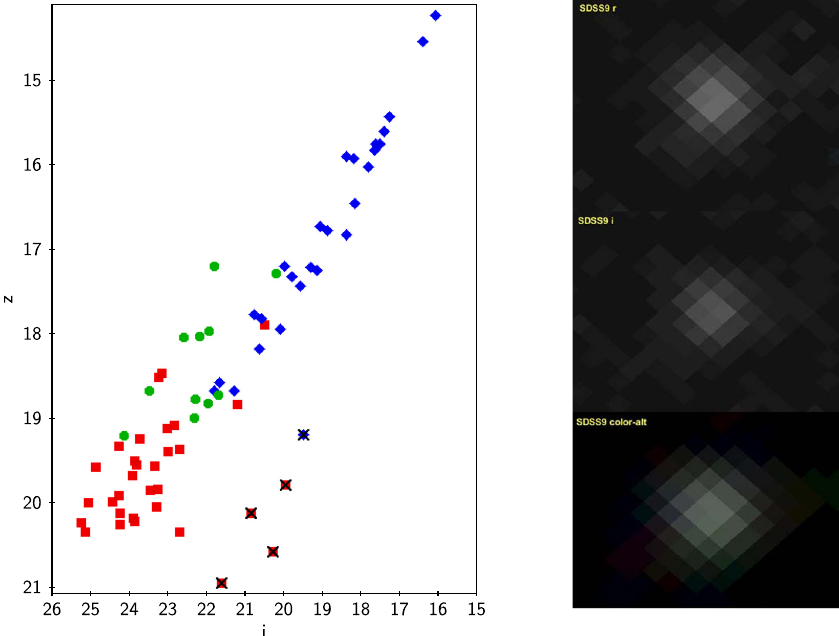
Figure 5: Results of the crossmatching on magnitude – magnitude diagram ( left ) . Image of the match found for WISEPC J234446.25 + 103415.8 in SDSS DR12 ( right ) in fi lters r and i and CDS color composition image.